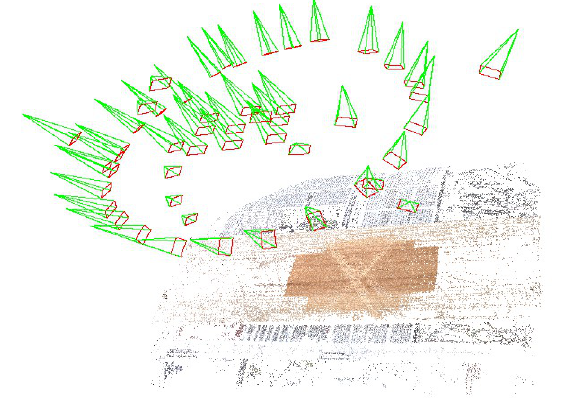
Figure.8. 3D model after computing camera poses